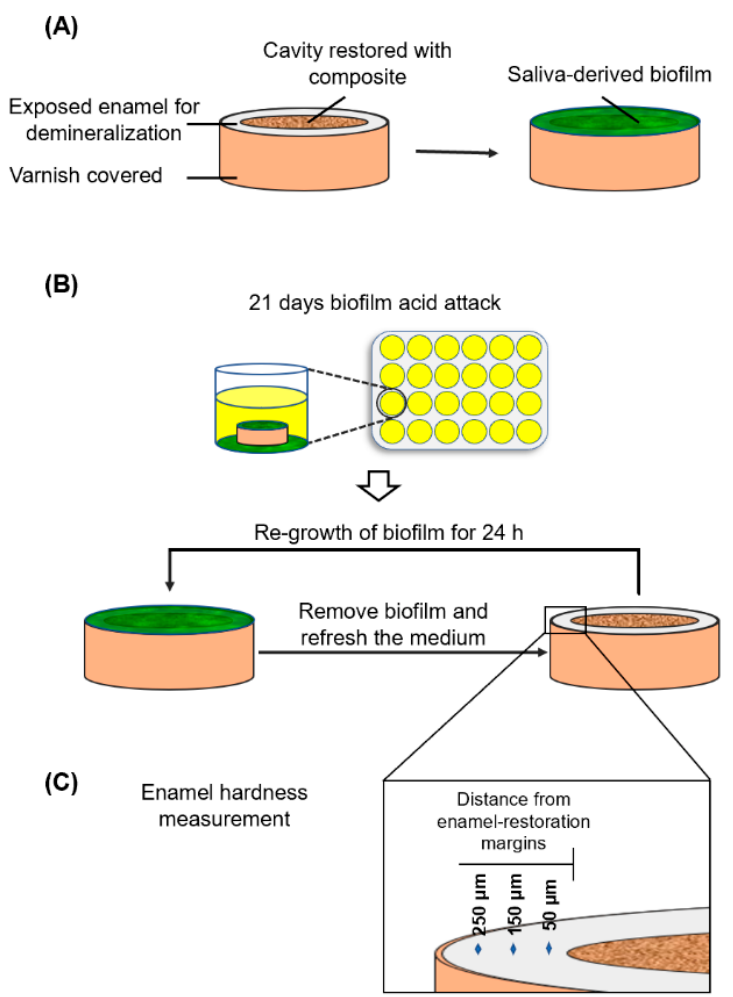
Figure 7. Schematic diagram illustrating the workflow of establishing saliva-derived biofilm secondary caries model. ( A ) Enamel slabs were restored with composites. Saliva-derived biofilm was formed on the specimens. ( B ) 21-day biofilm acid attack. ( C ) Enamel hardness measurement